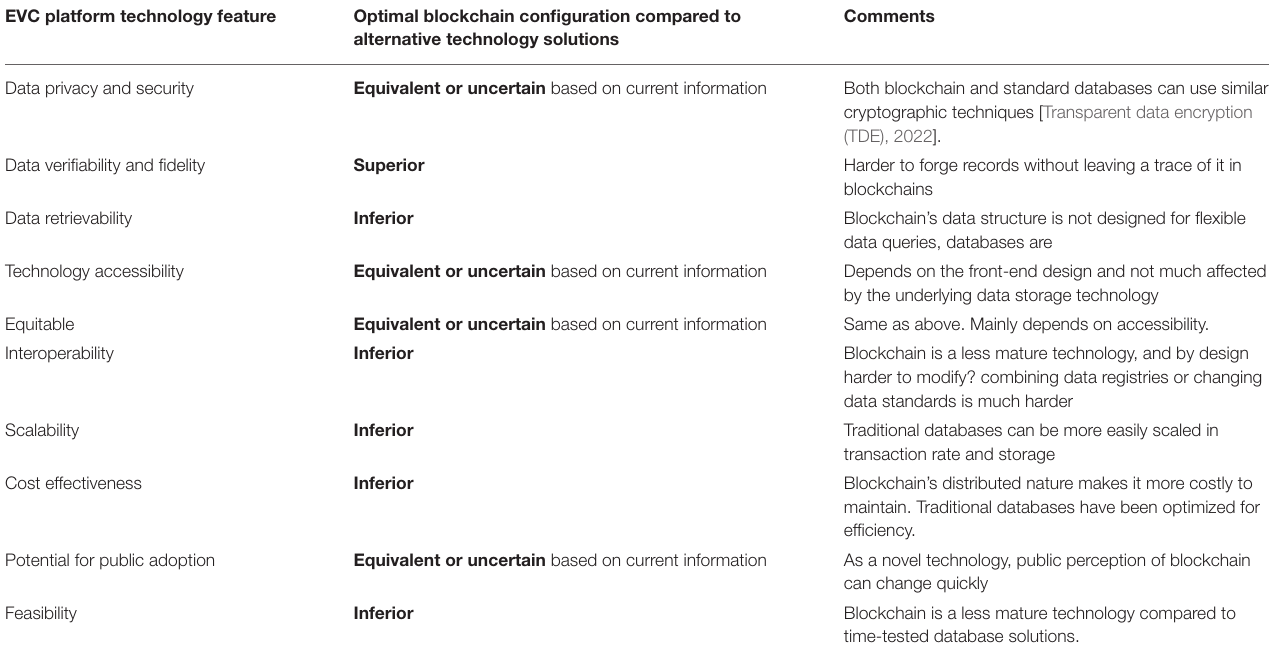
TABLE 3 | Comparison of blockchain and alternative technologies regarding EVC requirements. EVC platform technology